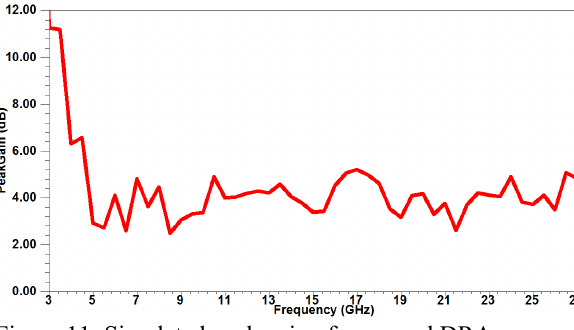
Figure 11: Simulated peak gain of proposed DRA